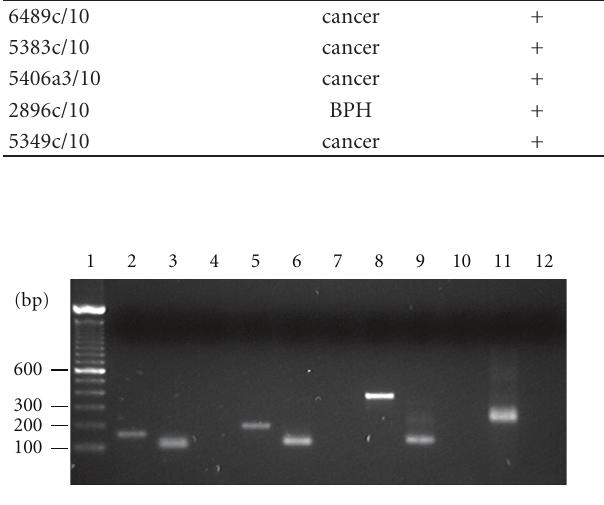
Figure 1: lane 1: MWM; lanes 2–4: β -globin PCR on LNCaP DNA template 1st round product, 2nd round product, and no- template control; lanes 5–7: XMRV LTR PCR on VP62 plasmid DNA template 1st round product, 2nd round product, and no- template control; lanes8–10: MuLV gag PCR onVP62 plasmidDNA template 1st round product, 2nd round product, and